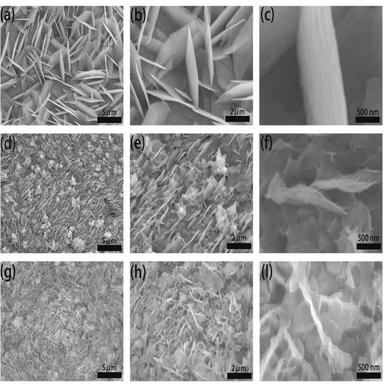
Typical low and high magnification SEM images of the (a–c) MCO electrode and (d–f) MCO@NS electrode. (g–i) MCO@NS electrode after 2000 cycles.